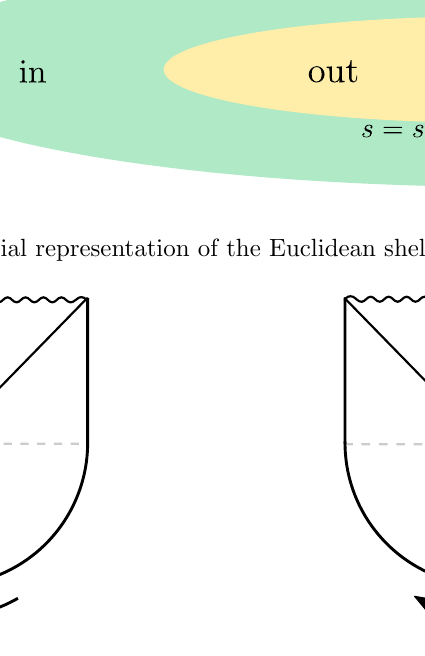
Figure 16 . Representation of the analytic continuation to Lorentzian of a single Euclidean black hole geometry (left) and of the Euclidean shell geometry constructed here (right). In the latter case, the continued geometry describes the backreaction to the presence of the homogeneous shell of dust that falls into a black brane geometry from a radial location r = s 0